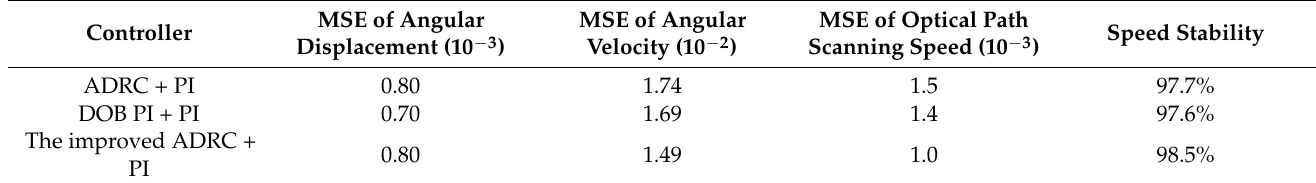
Table 5. The tracking performance of the three controllers after adding